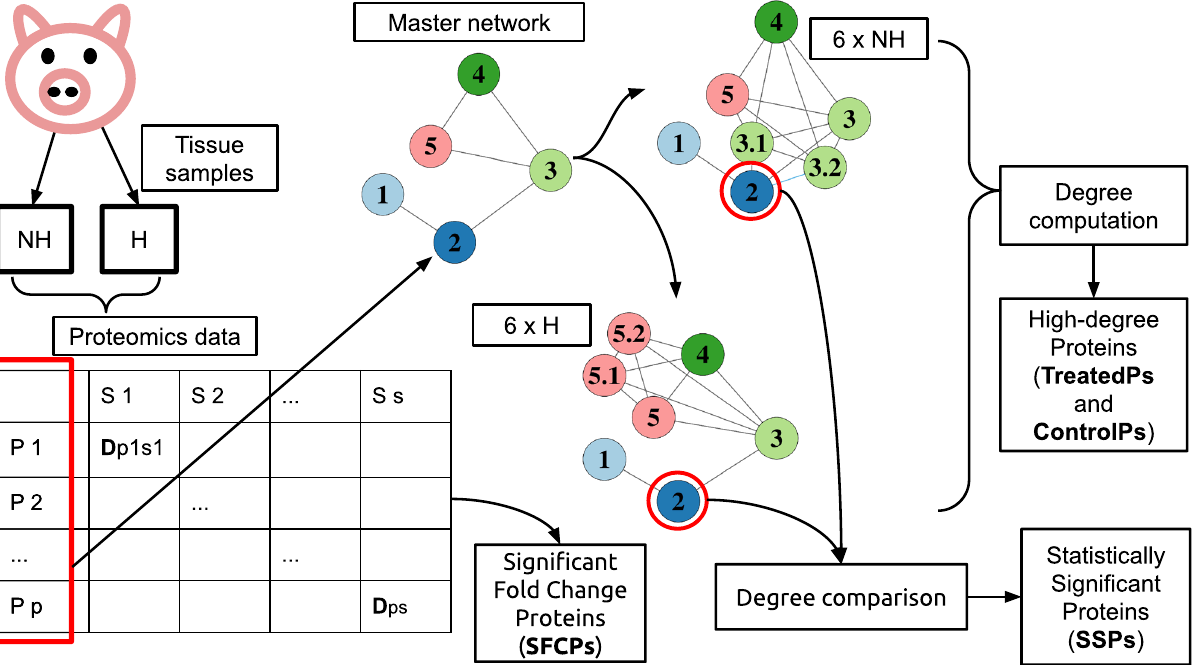
Figure 1. Analysis workflow. The analysis took advantage of a data set derived from myocardial tissue samples. Two types of samples were obtained: healthy control samples (NH or NU), and samples that suffered a heart attack and underwent a specific treatment (H or U). 24 samples were analysed using mass spectrometry to obtain a proteomics data set, represented as a matrix with a column for each sample and a row for each protein. The experimental information were used to construct WNNets and to compute fold change. Fold change was used to determine statistically significant differences between groups (SFCPs). The list of proteins, highlighted by the red box on the left, was used to construct the master network. The master network allowed the construction of 24 WNNets, each representing a tissue sample. Finally, degree was computed and high-degree proteins (TreatedPs and ControlPs) were identified. Degree was also used to test differences between groups at protein level, e.g. P2 from 6 H samples was compared to the degree of its corresponding healthy control